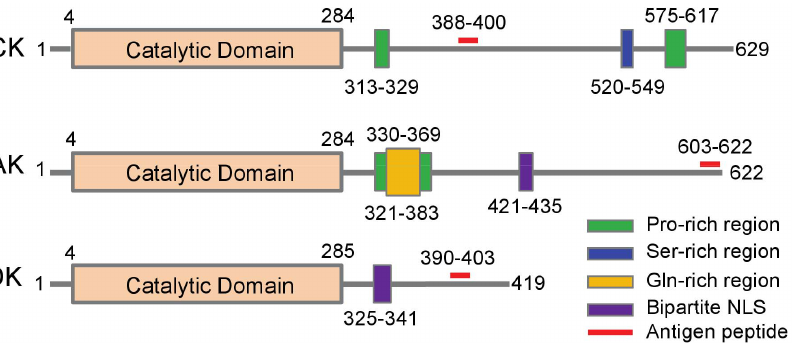
Figure 1. Schematic illustration of the structural domains and features of murine ICK, MAK and MOK protein kinases. Although ICK, MAK and MOK protein kinases are very similar in their N-terminal catalytic domains, they differ markedly in the structural organization and features in their C-terminal non-catalytic domains. Note that the antigen peptides for ICK, MAK, and MOK proteins are all located at the C-terminal domain by design so as to ensure the antibody